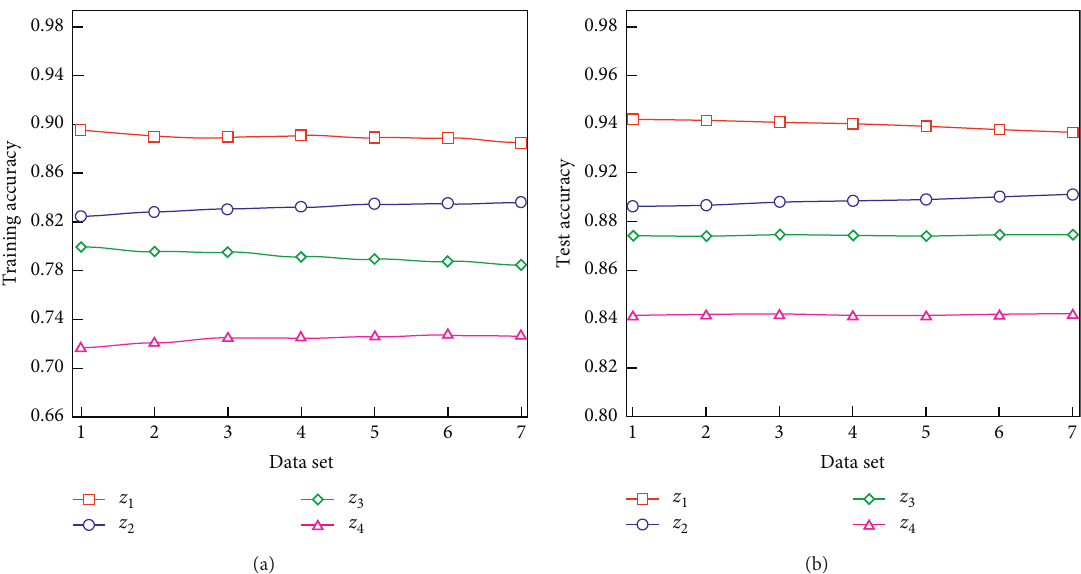
Figure 5: Matching training accuracy and test accuracy of four typical children’s psychological distresses. z social scene matching; z 3 , entertainment scene matching; z 4 , learning scene matching.